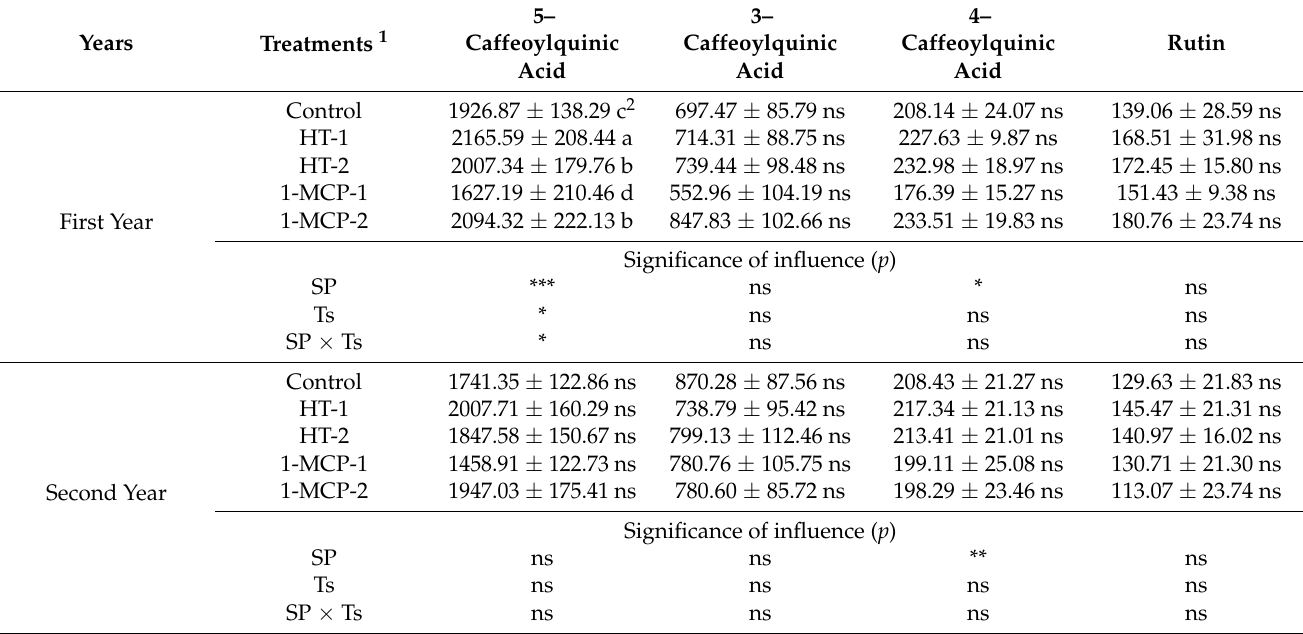
Table 3. The effect of different postharvest treatments on phenolic compounds (mg · kg − 1 fresh weight (FW)) of quince